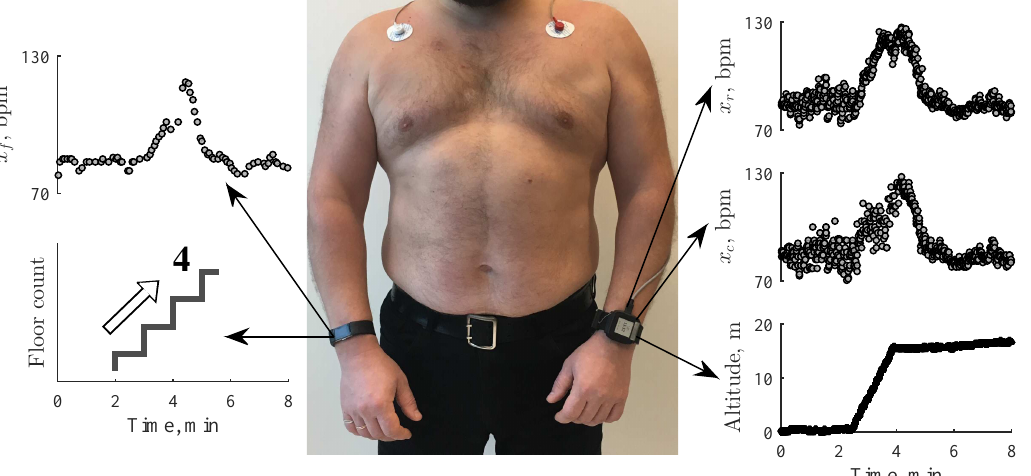
Figure 1. A custom-made wrist-worn device capable of acquiring reference electrocardiogram (ECG) ( x r ), photoplethysmogram (PPG) ( x c ), and barometric pressure (left arm). For comparison, heart rate ( x f ) was synchronously obtained using a consumer smart wristband Fitbit Charge 2 (right arm).